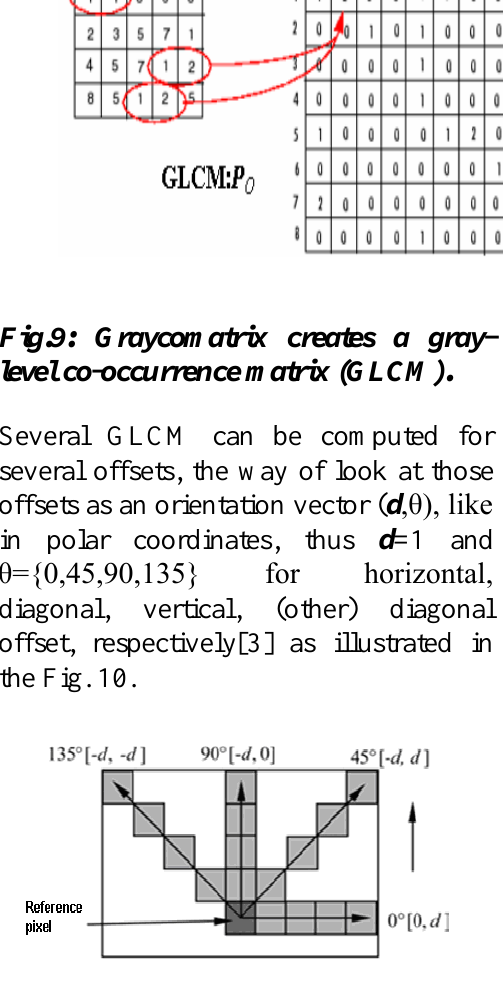
Fig.10: Co- occurrence matrix offset and its direction definition